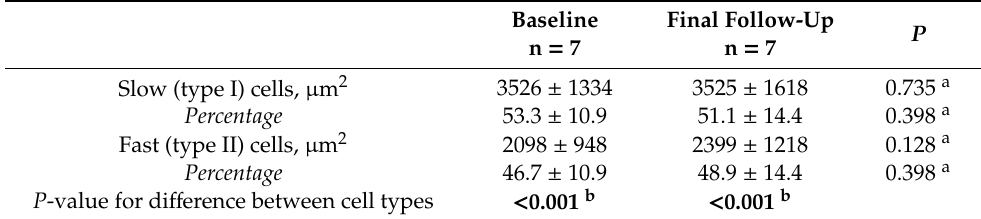
Table 6. Mean cross-sectional area and proportions of type I and II fibers measured with immunohistological